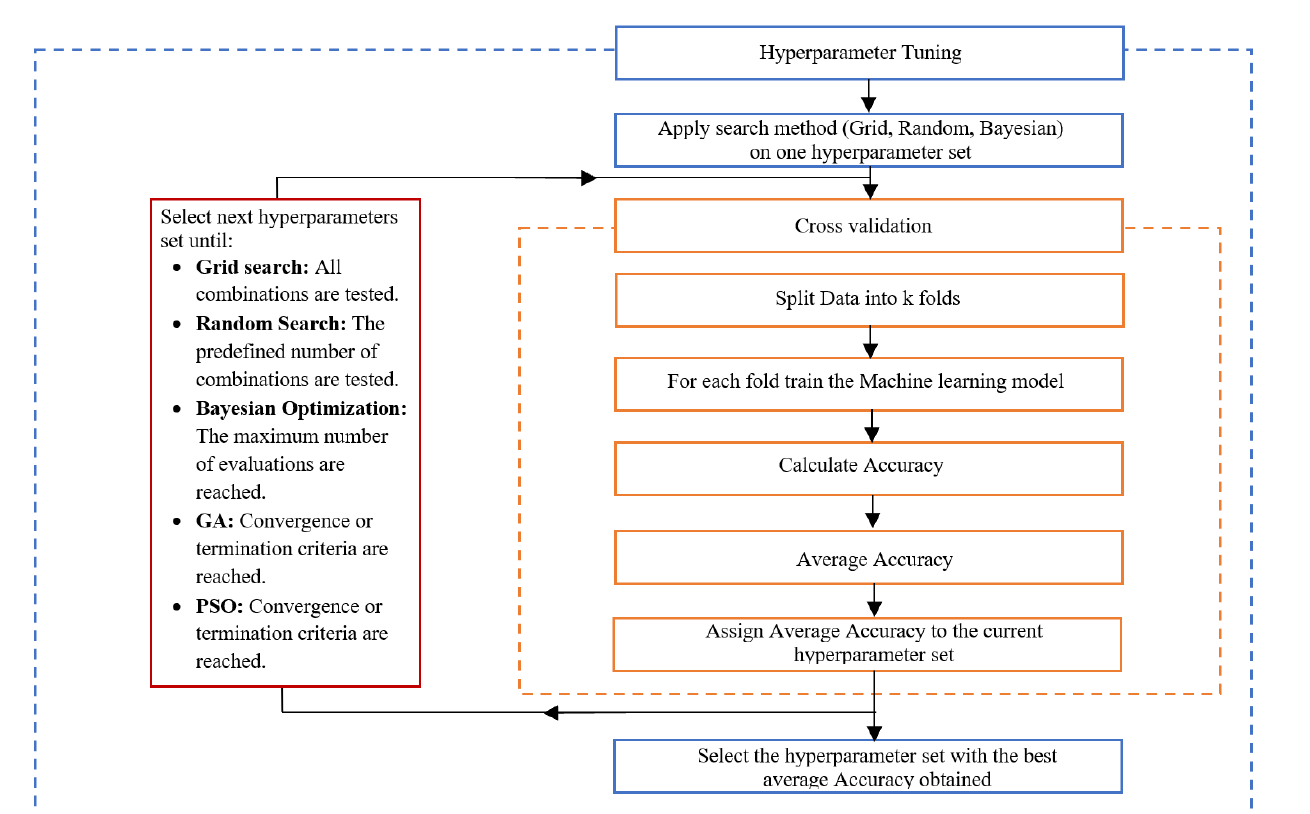
Figure 2. Hyperparameter tuning